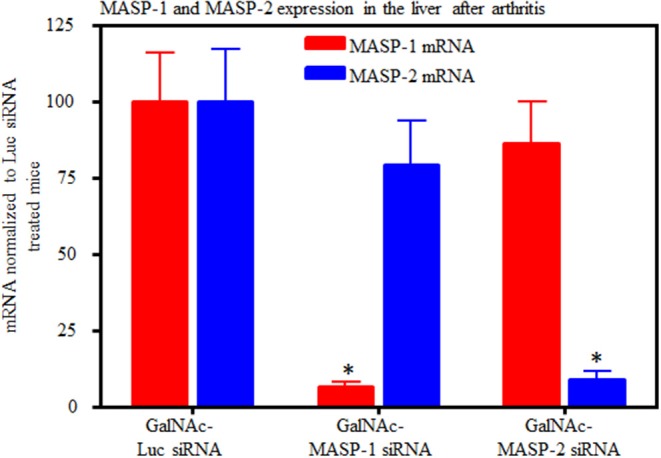
Quantitative RT-PCR analysis of MASP-1 and MASP-2 expression from the liver of WT arthritic mice injected with GalNAc-Luciferase-siRNA or GalNAc-MASP-1-siRNA or GalNAc-MASP-2-siRNA duplexes (n = 10 per group). Total RNA was extracted at day 10 from the liver of mice injected s.q. with multiple doses of GalNAc-MASP-1-siRNA or GalNAc-MASP-2-siRNA duplexes. MASP-1, MASP-2, and MASP-3 expression was examined using qRT-PCR. Liver from WT mouse was used as a positive control. Endogenous GAPDH mRNA expression was used as an internal control to normalize the expression of MASP-1 and MASP-2. *p < 0.05 vs. mice injected with GalNAc-Luciferase-siRNA.